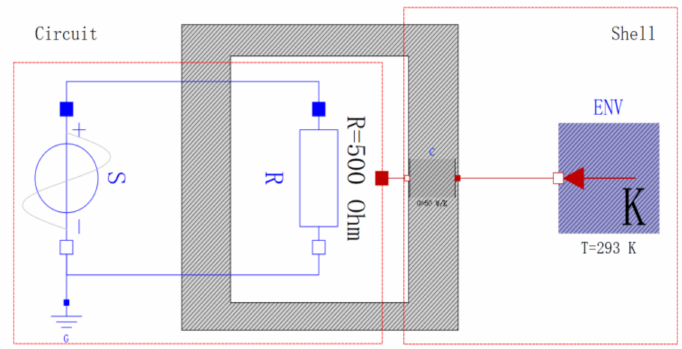
Figure 6. Example system to illustrate the structural analysis of NLAE models.